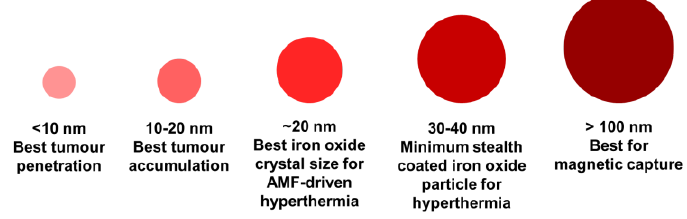
Figure 3. Preferential application of iron oxide magnetic nanoparticles according to their size.